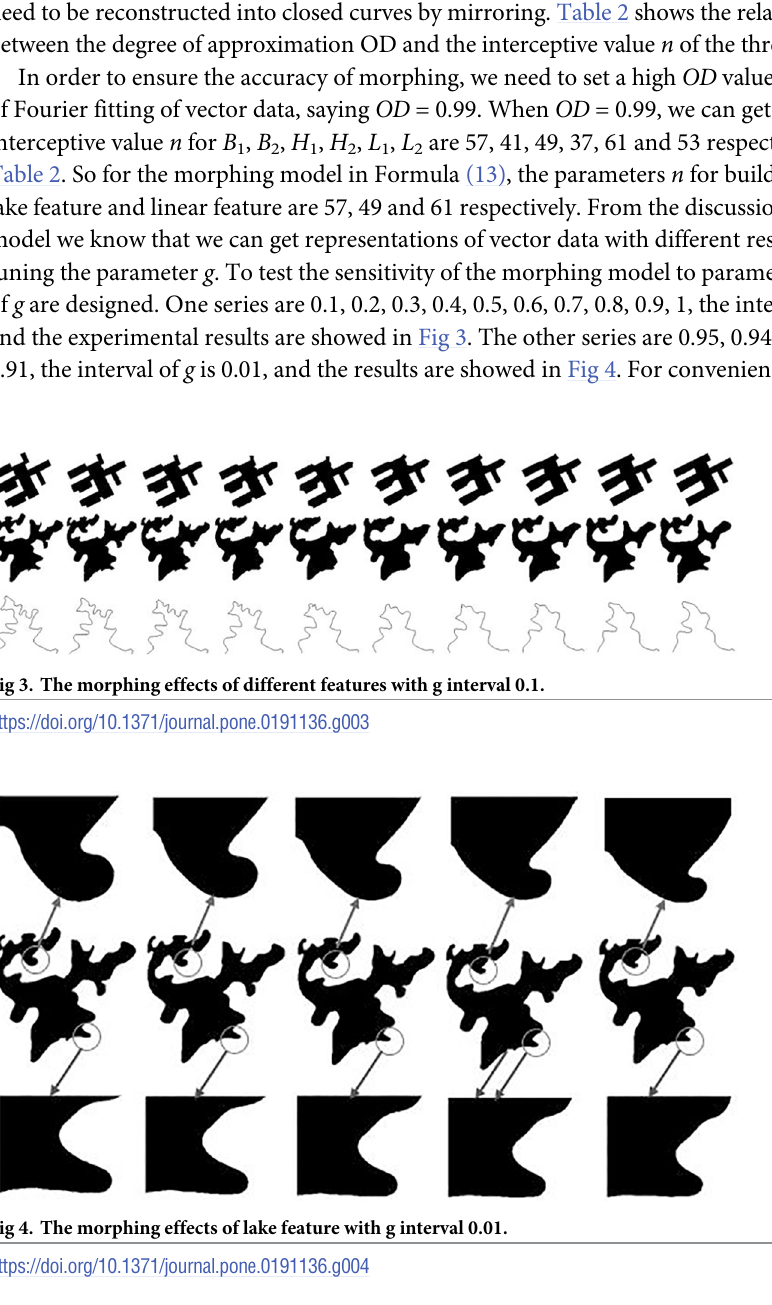
Fig 4. The morphing effects of lake feature with g interval 0.01.